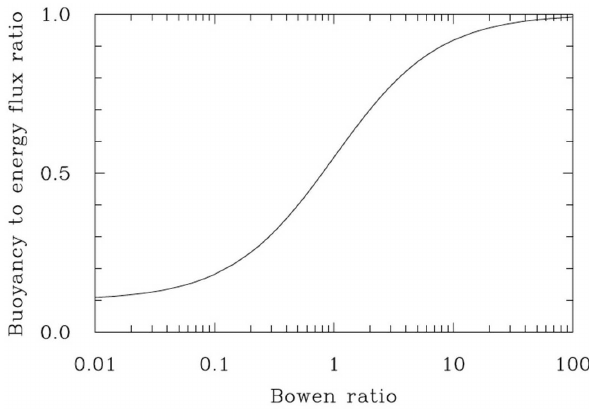
Figure 2. The ratio of the surface buoyancy flux to the total energy flux (sensible plus latent) as a function of the Bowen